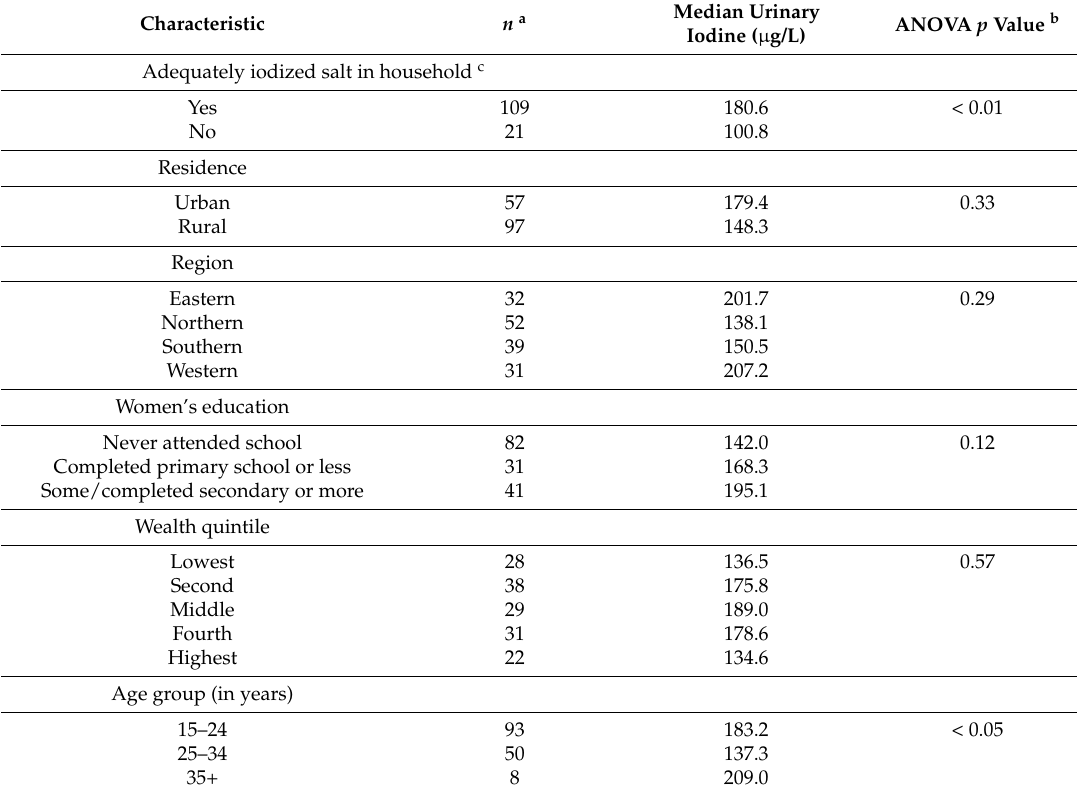
Table 2. Median urinary iodine in pregnant women, Sierra Leone